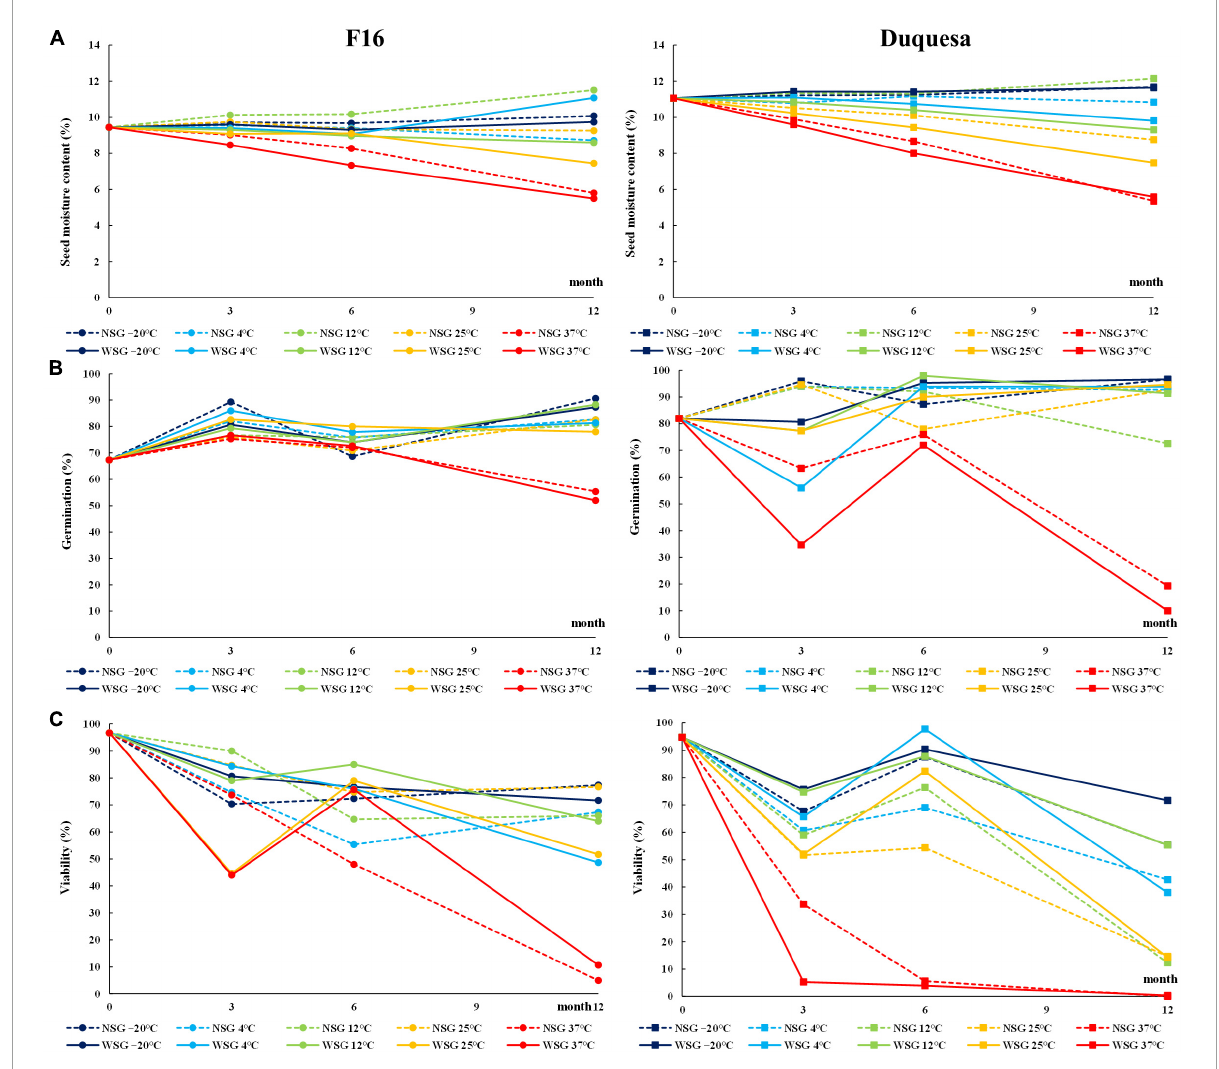
FIGURE1 Physiological characteristics of quinoa seeds. (A) Evolution of SMC in F16 (left) and Duquesa (right) seeds over time. (B) Evolution of germination capacity 1 day after sowing over storage time. (C) Viability measured through the TFT method over storage time. NSG, seeds stored without silica gel; WSG, seeds stored with silica